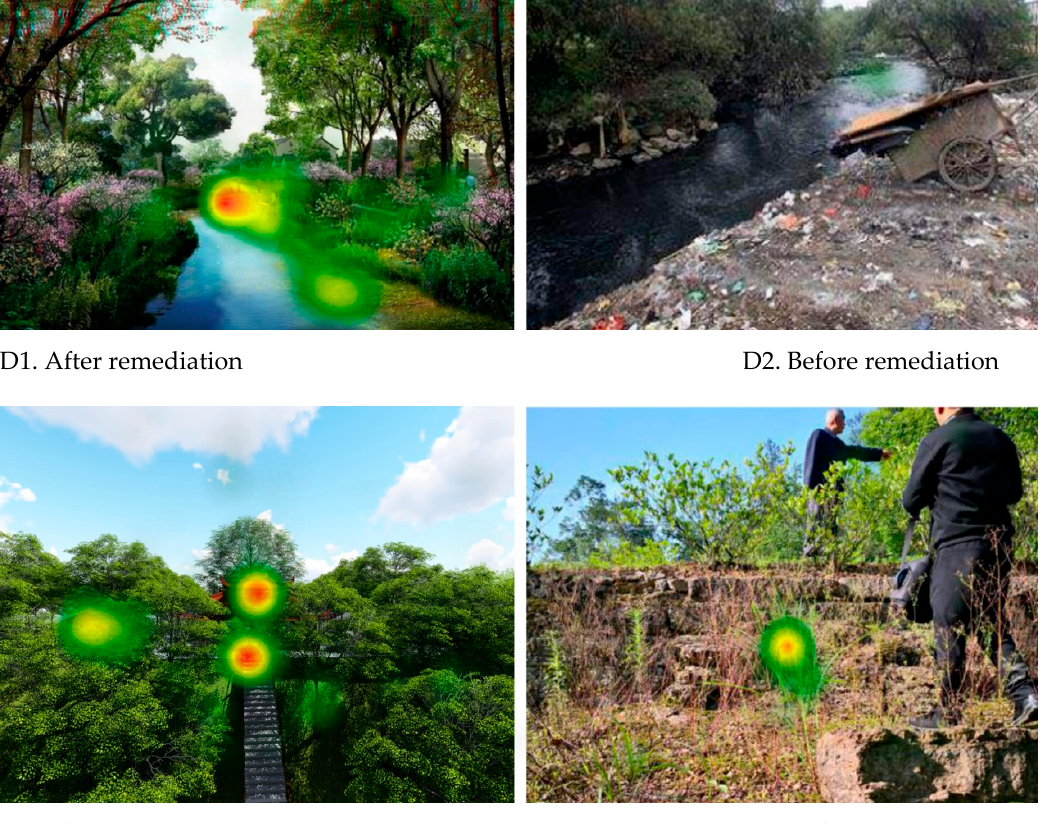
Figure 6. Distribution of fixation hot spots of subjects before ( right ) and after ( left ) the remediation design project. Group ( A – E ) images come from the distribution of fixation hot spots before and after the restoration of cultural relics cross-sections of Shizhuguan Temple, Xiangwangjie Temple, Wuluozhonglishan Temple, Miaolingshan Temple, and Hanyangqiao Temple.